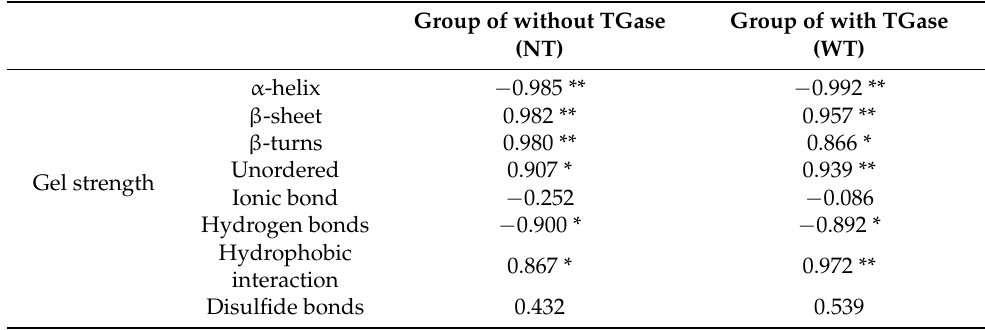
Table 5. The correlation analysis on fracture coefficient with chemical force and secondary structure of D. maruadsi surimi products under different thermal treatment